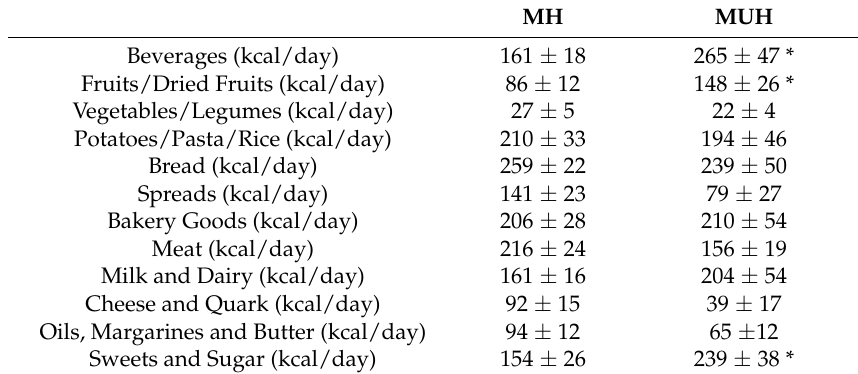
Table 4. Dietary patterns of healthy children and children suffering from metabolic disorders.